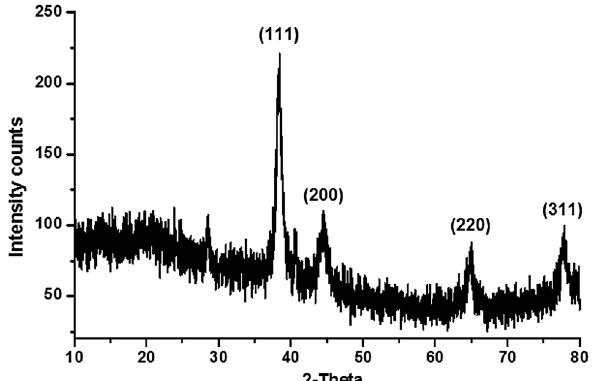
Figure 3. XRD pattern of gold nanoparticle.